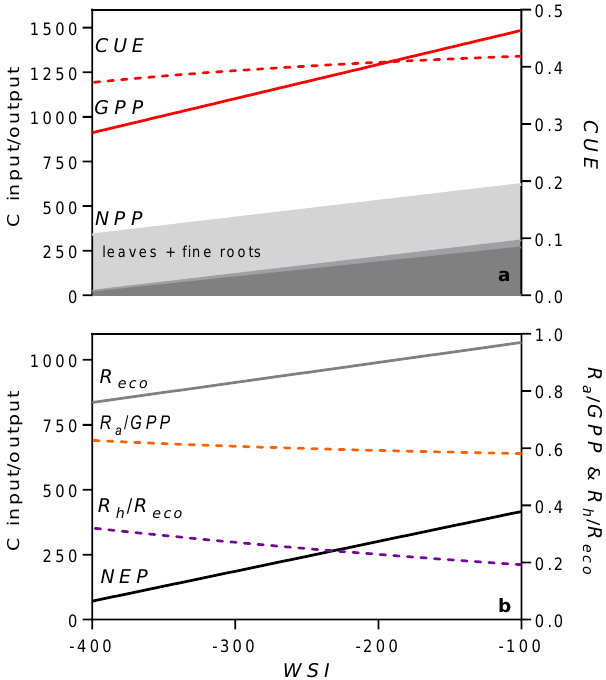
Figure 7. (a) Change in the partition of gross primary productivity (GPP), expressed in gCm − 2 yr − 1 , with increasing drought inten- sity quantified by the WSI in MPa day. The red line displays the decline of GPP with decreasing WSI. The net primary productivity (NPP) components are perennial aboveground + belowground parts (dark grey), reproductive effort (flowers and fruits; medium grey) and leaves and fine roots (light grey), all expressed in gCm − 2 yr − 1 . The dashed red curve is for the CUE. (b) Change in ecosystem respiration ( R eco , grey line) and net ecosystem productivity (NEP) (dark line), both in gCm − 2 yr − 1 , with increasing drought inten- sity (WSI). The dashed orange line is for the R a / GPP ratio and the dashed purple line for the R h /R eco